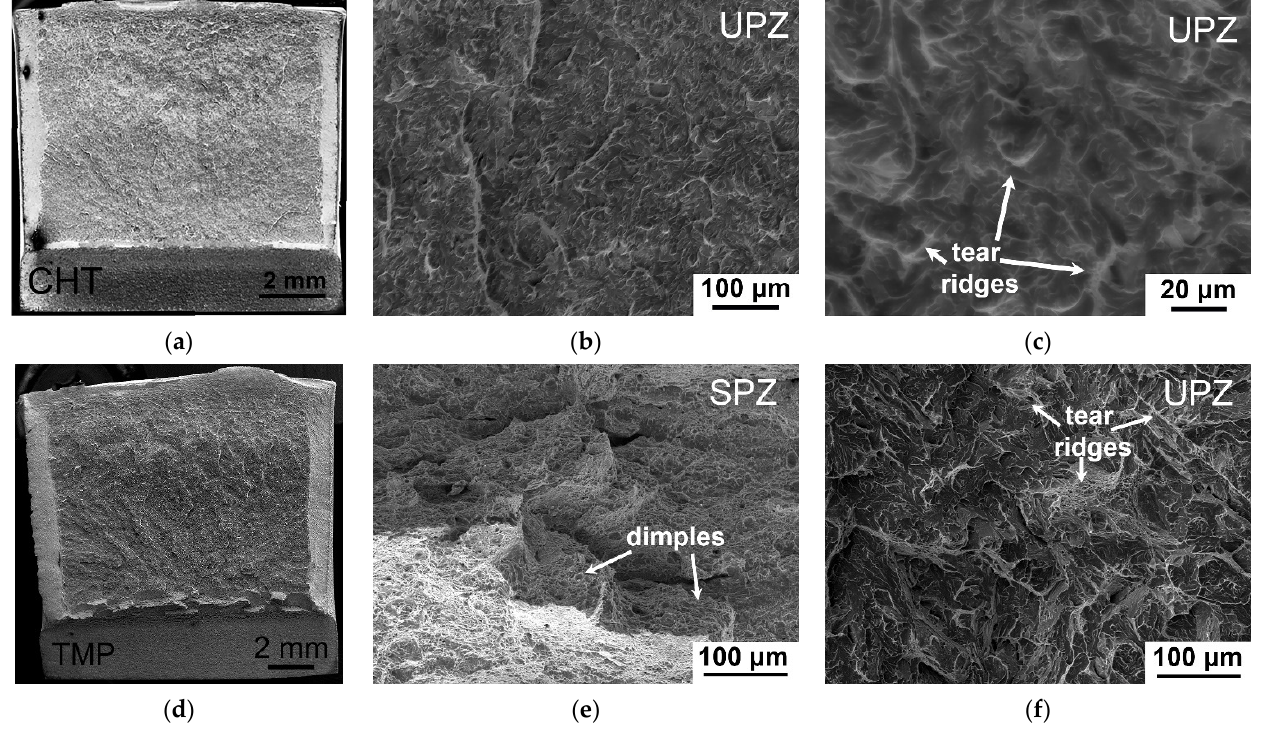
Figure 4. Fractography of the fractured surfaces in the stable (SPZ) and unstable crack propagation zones (UPZ) of the samples of the 12CrTaNb0.003N steel subjected to the CHT ( a – c ) and TMP ( d – f ) after the 25 °C impact test. Table 5. The length (in mm) of crack initiation zone (IZ), stable propagation zone (SPZ), unstable propagation zone (UPZ), and arrested zone (AZ) for the different 12% Cr steels after 25 ◦ C impact